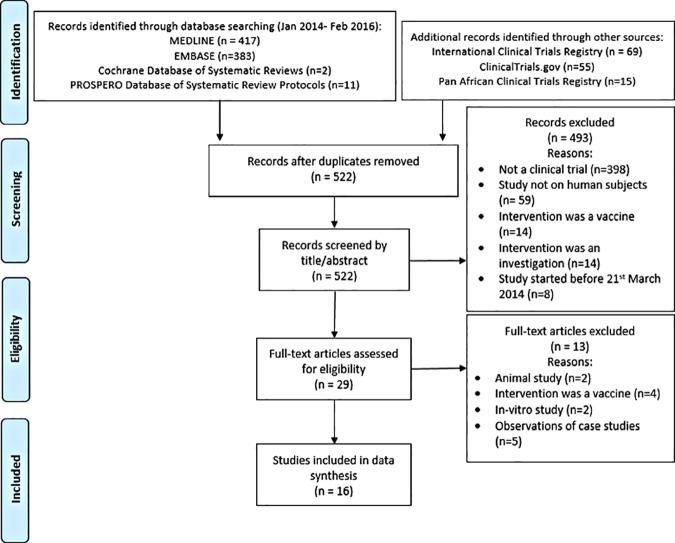
PRISMA Flow Diagram.